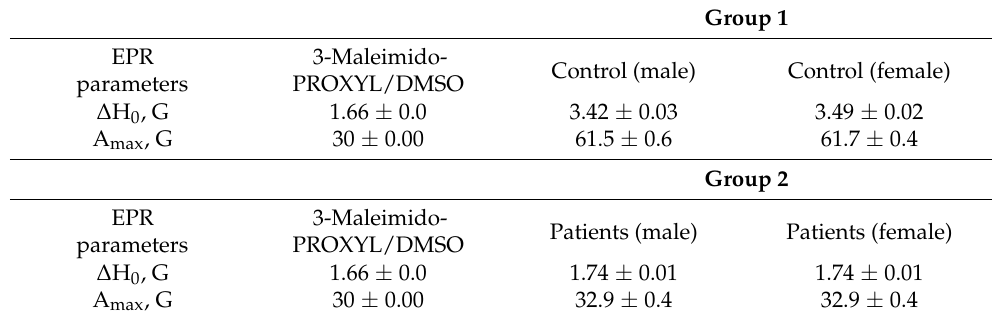
Table 4. EPR data includes marking and measuring the hyperfine splitting parameter A max between the external peaks (a and c), as well as ∆ H 0 of the central resonance line (b) in the EPR spectrum of nitroxide, which determines the degree of inversion of the radical and is a marker of its mobility. The results are presented as a mean ±